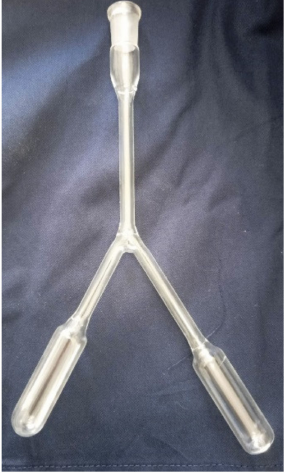
Figure 1. Double ampoule for the synthesis of the compounds 5 and 6